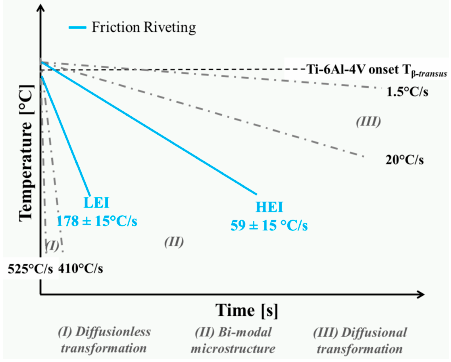
Figure 10. Schematic continuous cooling diagram for Ti-6Al-4V alloy including the calculated cooling rate of friction-riveted joints (adapted from [35]).